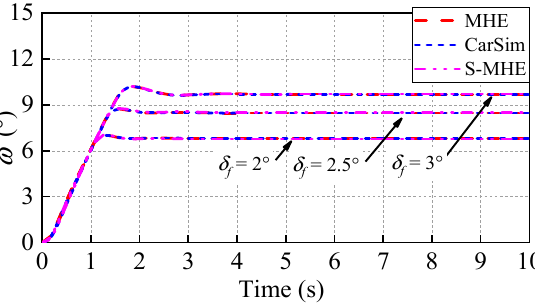
Figure 15. Yaw rate.